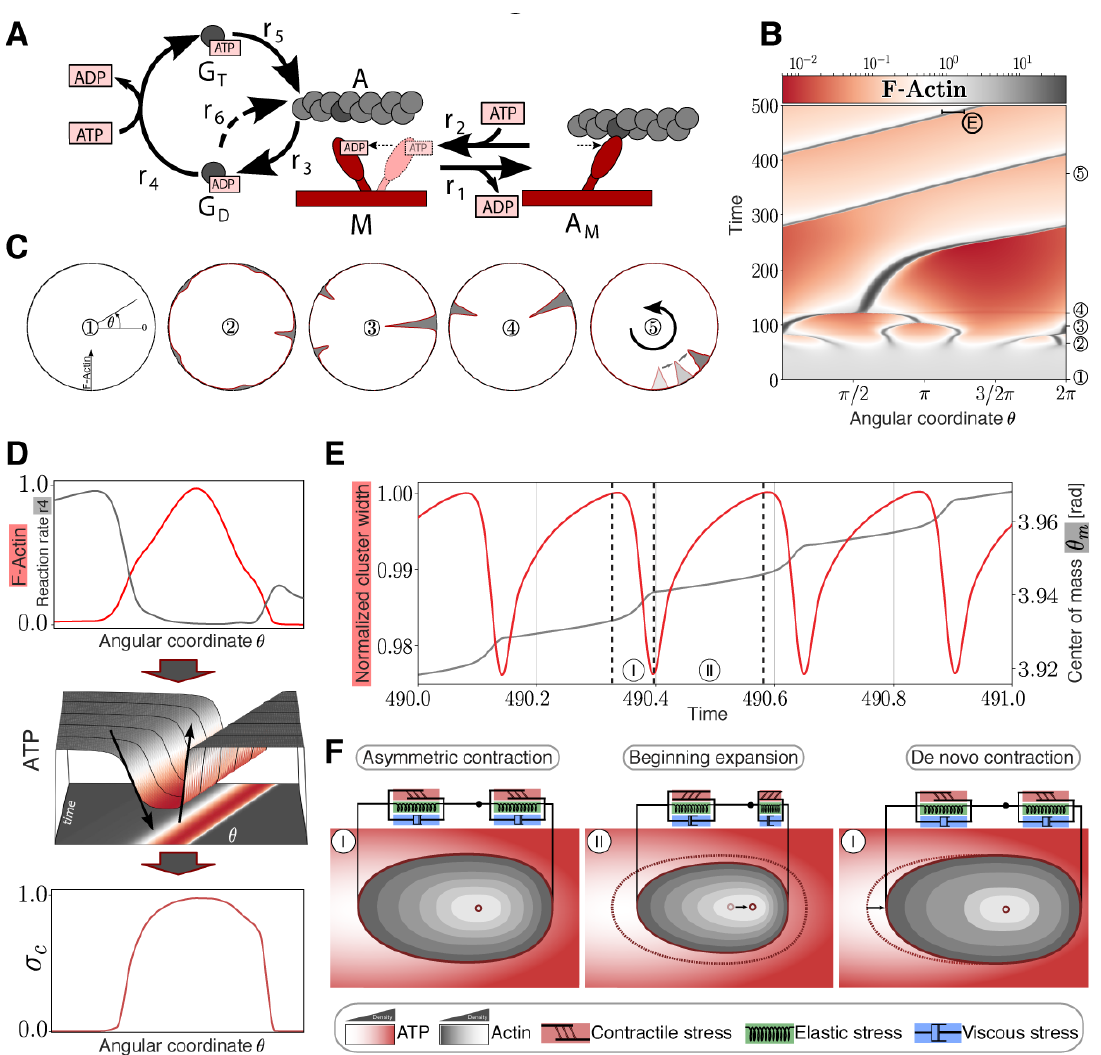
Figure 3. Modeling and simulation of actomyosin cluster motions reveal a propagation mechanism through active matter vibrations. ( A ) Kinetic reaction network with F-actin polymerization cycle and simplified myosin cross-bridge model. ( B ) Temporal development of a one-dimensional spatial F-actin distribution with color-coded local concentration. ( C ) Circular representation of distributed F-actin concentration according to the model topology for selected time points (marked in (B) with circles). ( D ) Non-symmetric contraction of a propagating cluster. Upper graph: Normalized distribution of reaction rate 4 (gray) compared to normalized F-actin cluster location (red). Middle graph: Non-symmetric ATP distribution around the cluster. Lower graph: Normalized asymmetric contractile stress pattern with color code representing ATP concentration according to the projection. ( E ) Vibration of an F-actin cluster. Evolution of normalized cluster width (red) and displacement of center of mass θ m (gray) of F-actin in radiant. Cluster boundaries are defined as the points where the F-actin concentration exceeds the mean concentration. ( F ) Sketch of the cortical actin cluster migration mechanism with qualitative color-coded Actin and ATP gradients shows repetitive asymmetric contractions (I) and an expansion phase (II) resulting in a shift of the center of mass according to (D) indicated by a black arrow (middle panel) and displacement of the cluster indicated by an arrow (right panel).